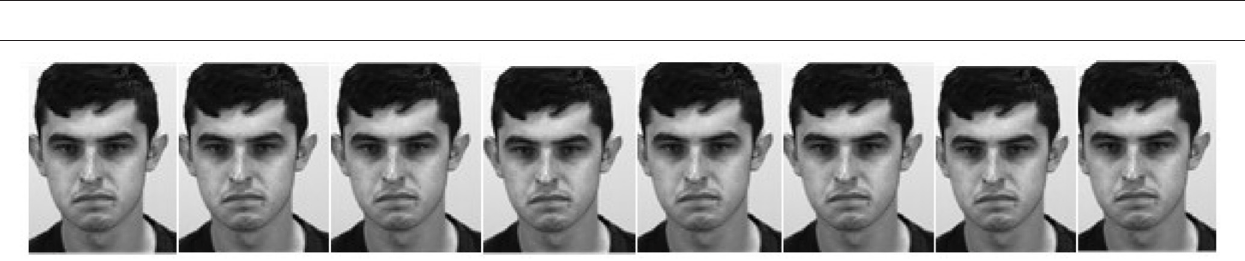
FIGURE 3 | Sample frames from a “Disgust” sequence (Subject 15) in CAS(ME) 2 . Images reproduced from the database ( © Xiaolan Fu) with permission from Qu et al. (2017) .